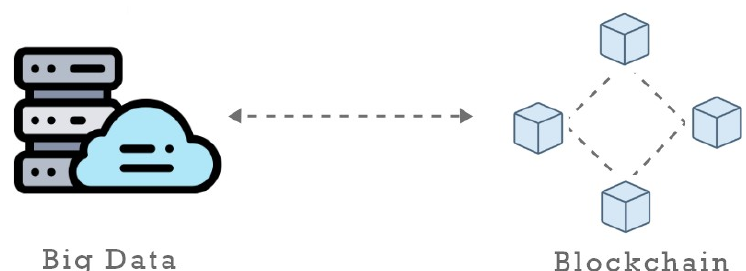
Figure 10. Blockchain in big data.